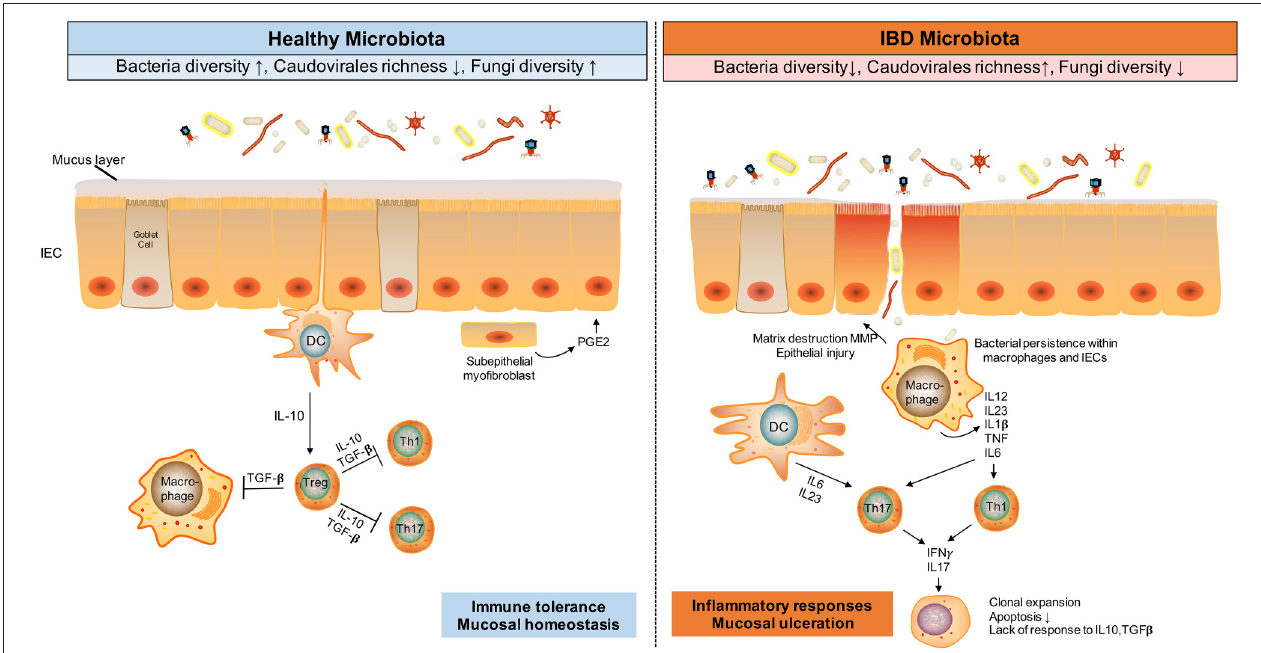
FIGURE 1 | Gut microbiota alteration and immune responses in IBD. The gut microbes, including bacteria, viruses and fungi, and dysfunctional immune responses, engaging Tregs, T-helper 1 (Th1), and Th17, are implicated in IBD pathogenesis. During homestasis, gut microbes induce an immune tolerance phenotype in the host, whilst in inflammatory conditions like IBD, antigens from dysbiotic microbes activate Th1 and Th17 cells, resulting in tissue injury, decreased mucus layer, and microbial penetration and persistence in the intestinal tissues. This mucosal injury results in further uptake of microbial antigens, TLR ligands, and viable organisms that perpetuate the immune responses. TGF, transforming growth factor; TGF, transforming growth factor; MMP, matrix metalloproteinase; DC, dendritic